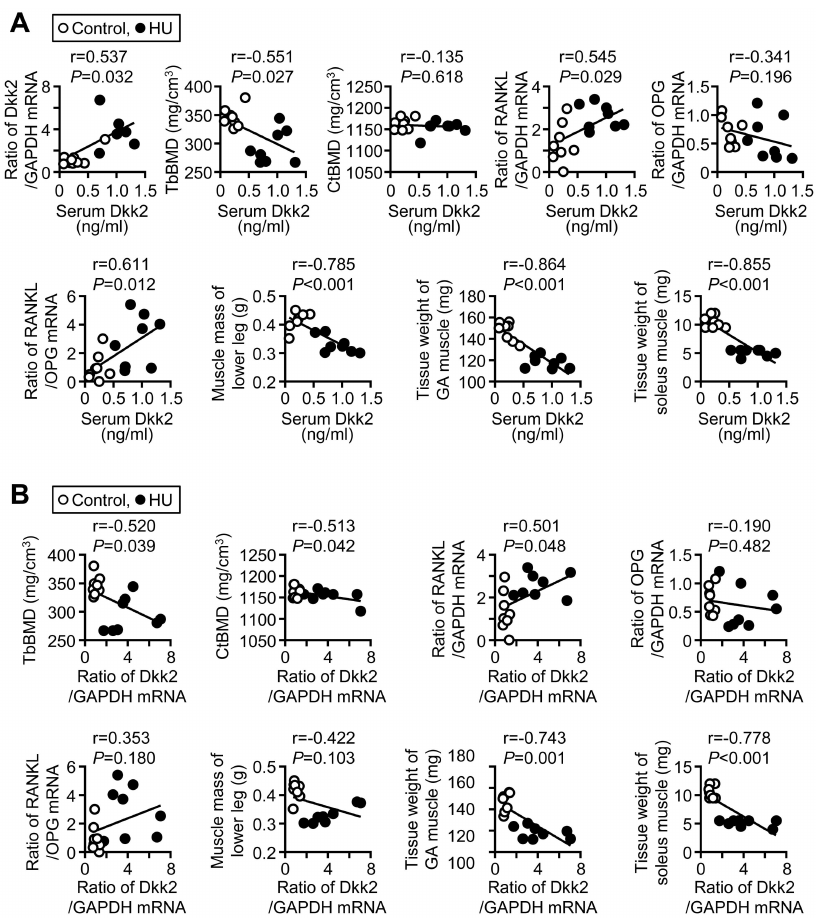
Figure 4. Relationship between Dkk2 and muscle / bone parameters in mice. ( A ) A simple regression analysis was performed between serum Dkk2 levels and Dkk2 mRNA levels in the soleus muscle, trabecular bone mineral density (TbBMD), cortical BMD (CtBMD), tibial nuclear factor-kappa B ligand (RANKL) mRNA levels, tibial osteoprotegerin (OPG) mRNA levels, ratio of RANKL / OPG mRNA in the tibia, muscle mass of lower legs or tissue weights of the gastrocnemius (GA) and soleus muscles in control mice and mice with HU for 3 weeks ( n = 8 mice in each group). ( B ) Simple regression analysis was performed between Dkk2 mRNA levels in the soleus muscle and trabecular BMD, cortical BMD, tibial RANKL mRNA levels, tibial OPG mRNA levels, ratio of RANKL / OPG mRNA in the tibia, muscle mass of lower legs or tissue weights of the gastrocnemius (GA) and soleus muscles in control mice and mice with HU for 3 weeks ( n = 8 mice in each